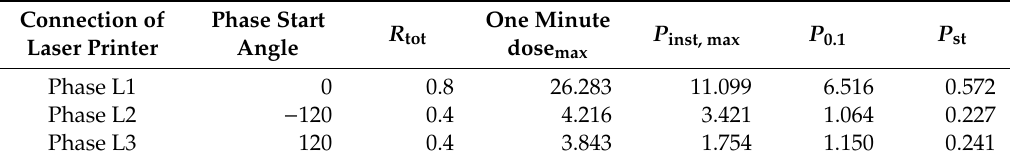
Table 2. Maximal one minute dose, P inst, P 0.1, and short term flicker P st for connection of laser printer to di ff erent phases, calculated with Matlab Simulink model shown in Figure